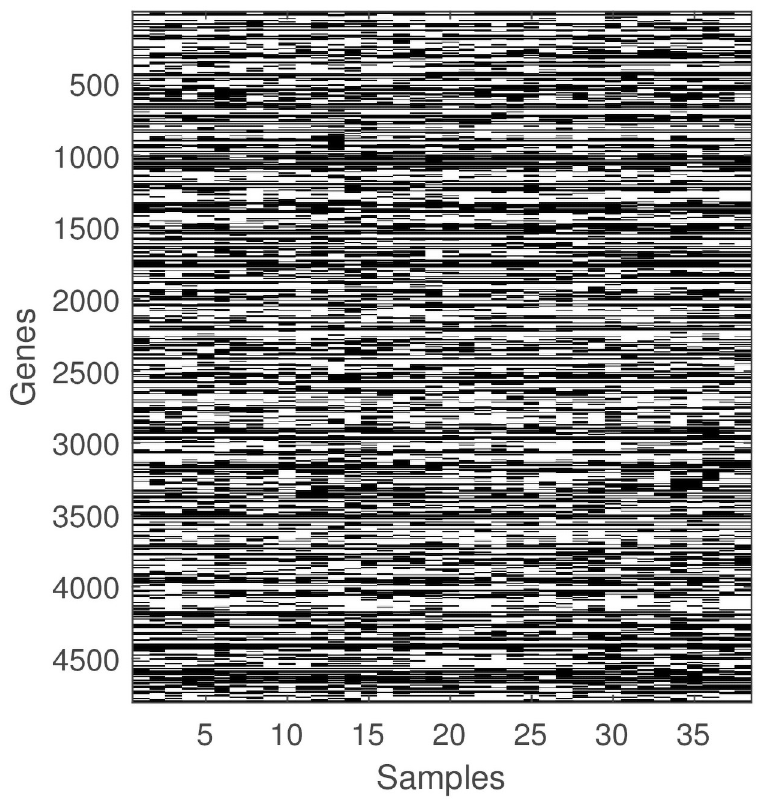
Fig 2. The thresholded leukemia data. Black entries are 1 and white entries are